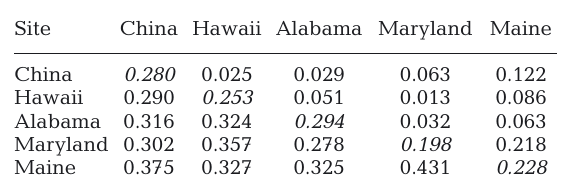
Table 2. Pair-wise genetic distance (% distance) estimates among the P. websteri mtCOI sequences within each popu- lation are shown along the diagonal (italics) while between- population total and net distance are given below and above the diagonal, respectively. Genetic distances were calcu- lated using the Jukes-Cantor model in Mega (ver6; Tamura et al. 2013). The single sequence from Massachusetts was not included in